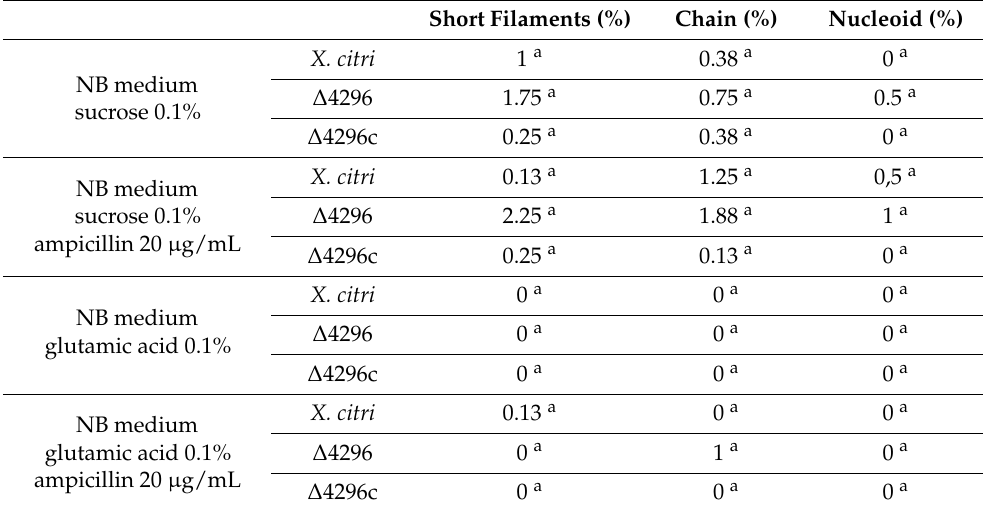
Table 4. Short filaments, chain, and aberrant nucleoid organization phenotype were restored to normal on NB medium with sucrose or ampicillin and NB medium with glutamic acid or ampicillin. Short Filaments (%) Chain (%) Nucleoid (%) X. citri 1 a NB medium sucrose 0.1%